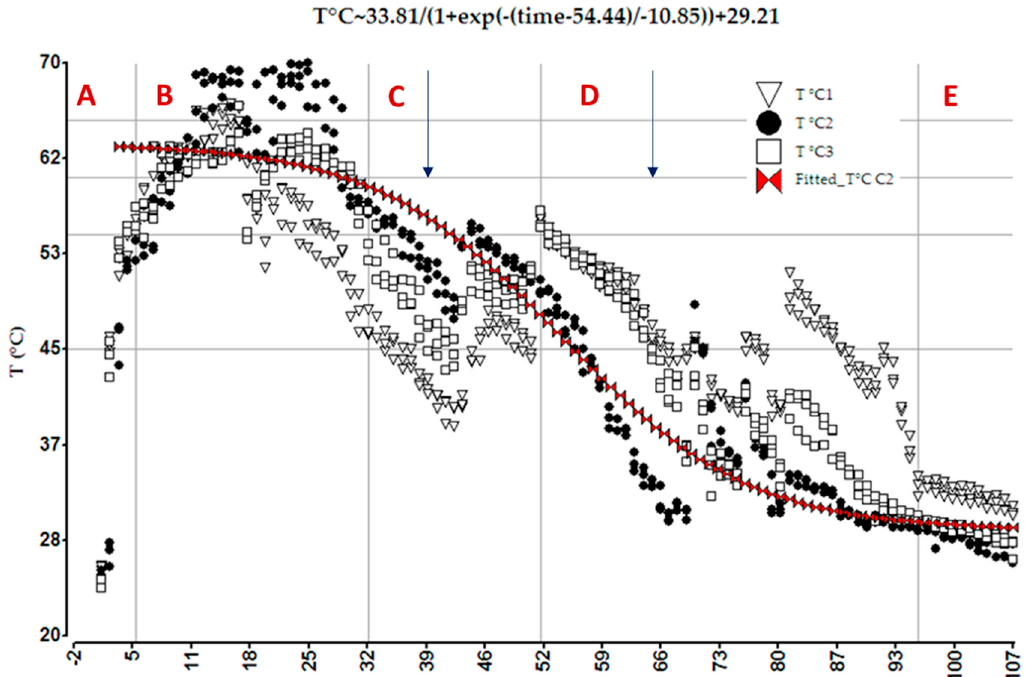
Figure 1. Measurement of daily temperature in piles C1, C2, and C3 (each point is the average measurement of the three repetitions). The arrows indicate when the piles were turned. A: mesophilic phase, up to day 11, with homogenous temperatures between the 3 mixtures ( p < 0.0001); B: thermophilic phase, corresponding to days 12–29, with temperatures over 45 °C, and with decreasing temperatures as follows: C1 > C3 > C2 ( p < 0.0001); C: second mesophilic phase, with